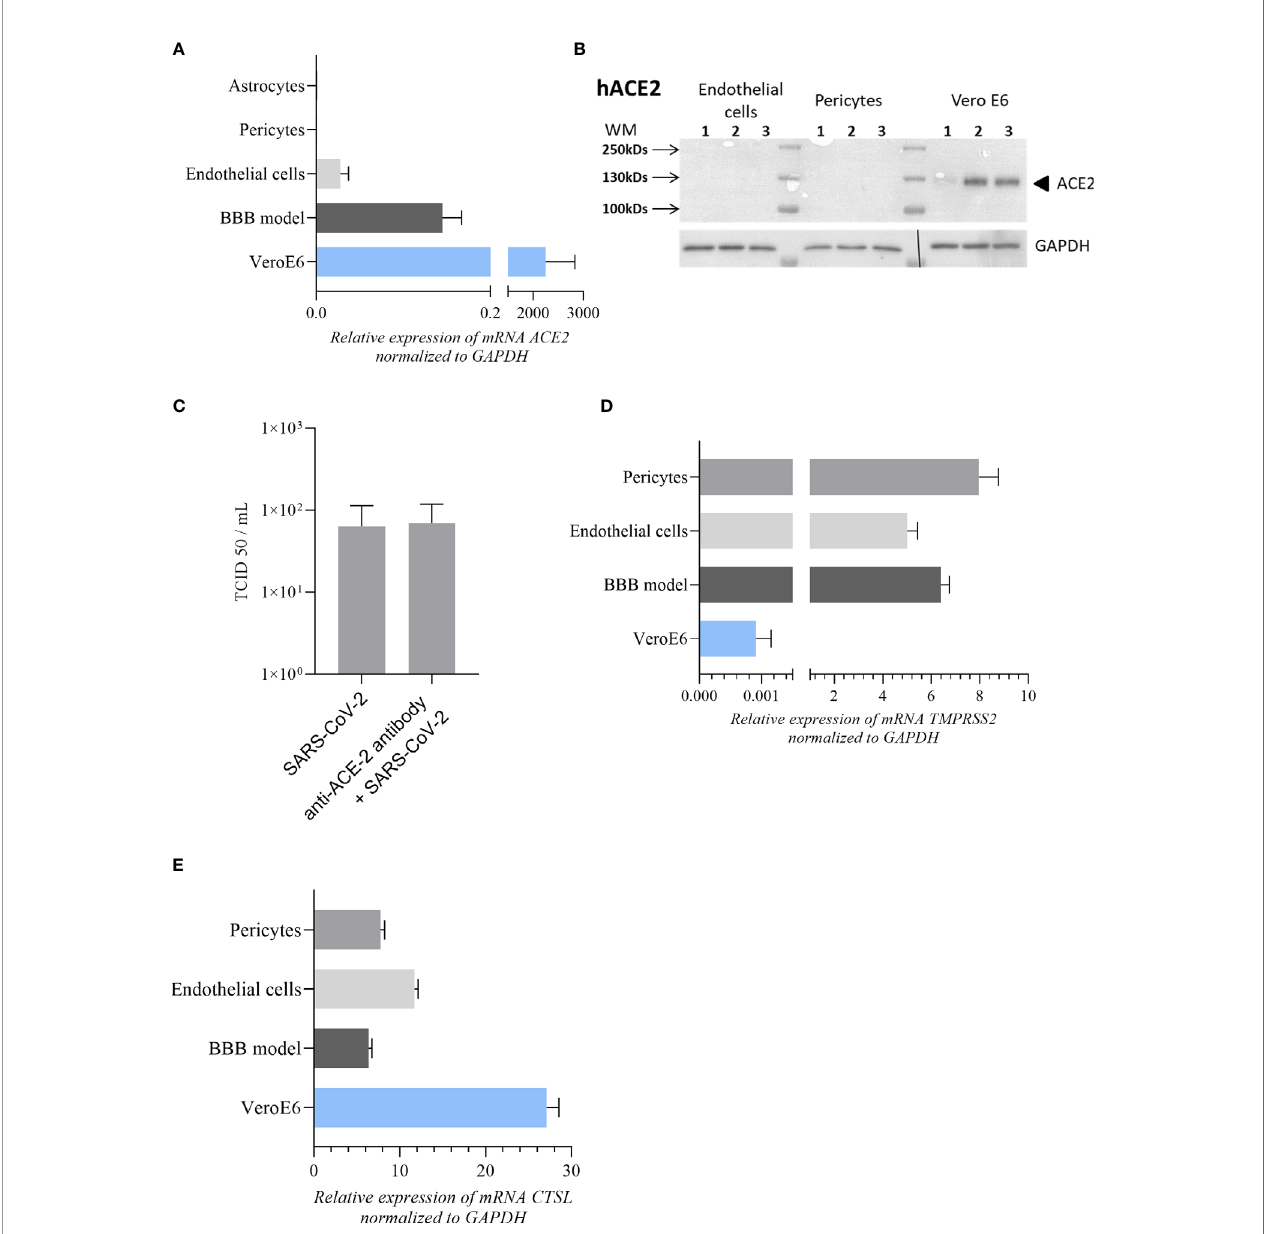
FIGURE 3 | Expression of mainSARS-CoV-2 cellreceptorsin ourcellmodels (A) ACE-2 mRNA expression inastrocytes, pericytes, BBB modeland endothelial cellsin comparison to VeroE6 cells (highly permissive to SARS-CoV-2 infection). (B) No detectableexpression of ACE-2 protein bywesternblot inendothelial and pericytes cells contrary to VeroE6 cells. (C) TCID50 measurements of SARS-CoV-2 in CECs at 2 dpi after treatment with anti-ACE-2 antibody. TCID50 measure results are expressed as mean ± SEM. (D, E) Respectively TMPRSS2 and CTSL mRNA expression inBBB model,pericytes and endothelial cells incomparisonto VeroE6